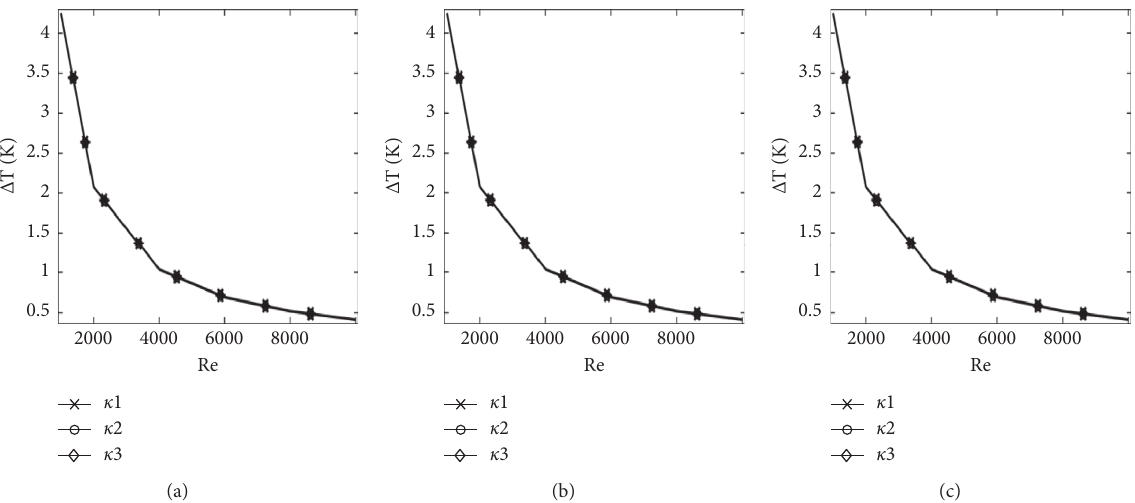
Figure 10: Rise of the temperature from inlet to the surface of the circular cylinder for all resistance coefficients: (a) θ � π /6; (b) θ � π /4; (c) θ � π